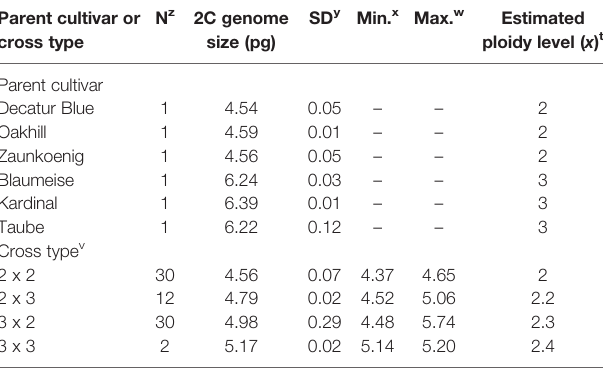
TABLE 4 | Genome size and estimated ploidy for parent cultivars and offspring of Hydrangea macrophylla interploidy and intraploidy crosses. Parent cultivar or N z 2C genome SD y Min. x Max. w cross type